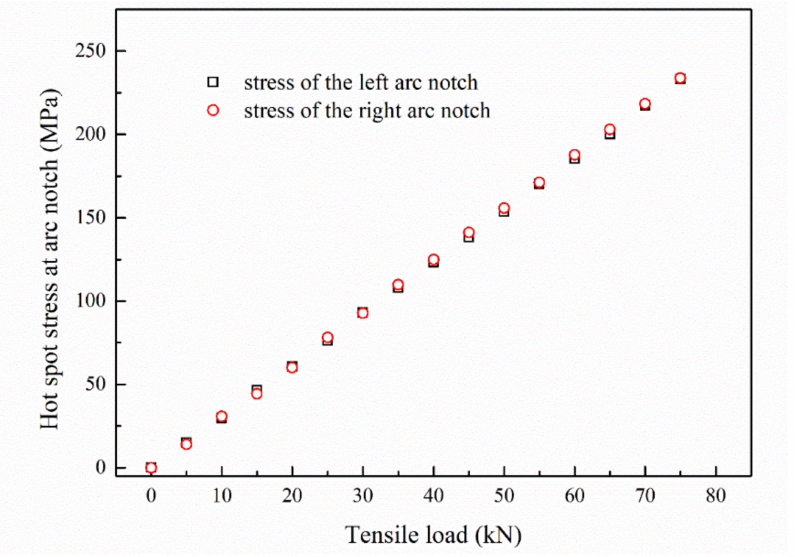
Figure 13. The relationship between tensile load and hot spot stresses at the left and the right arc